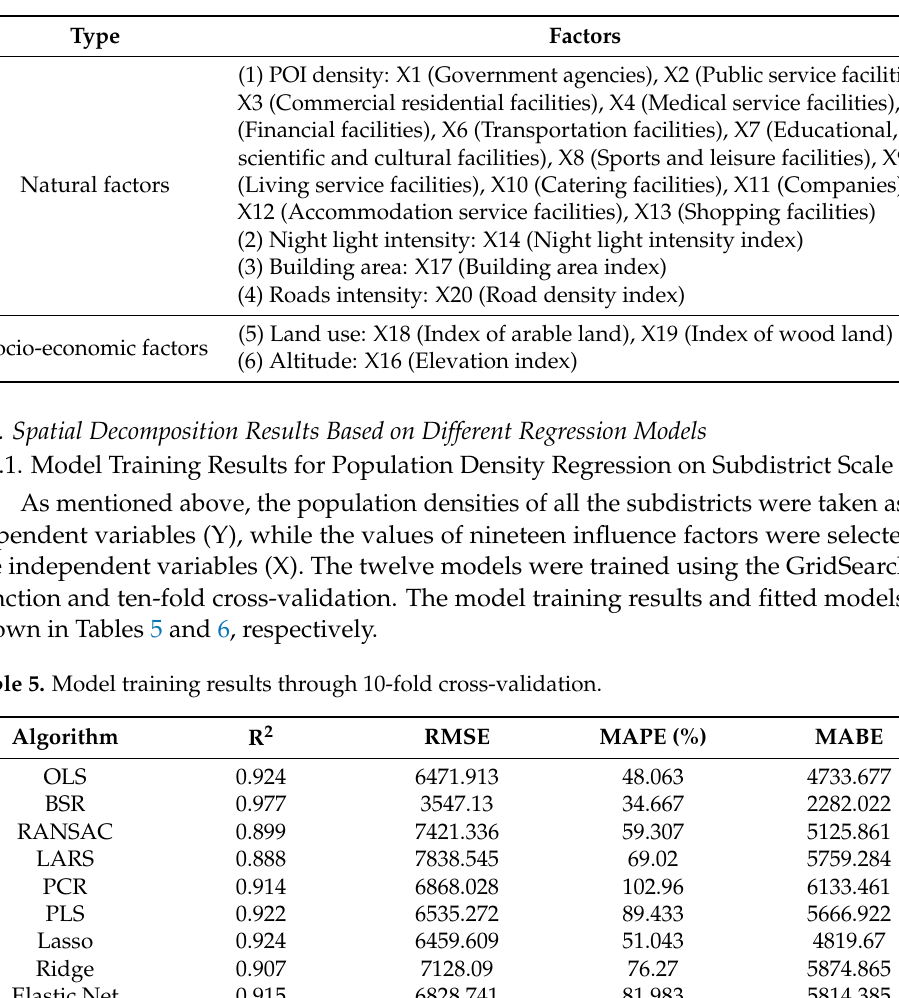
Table 4. The final independent variables for regression.